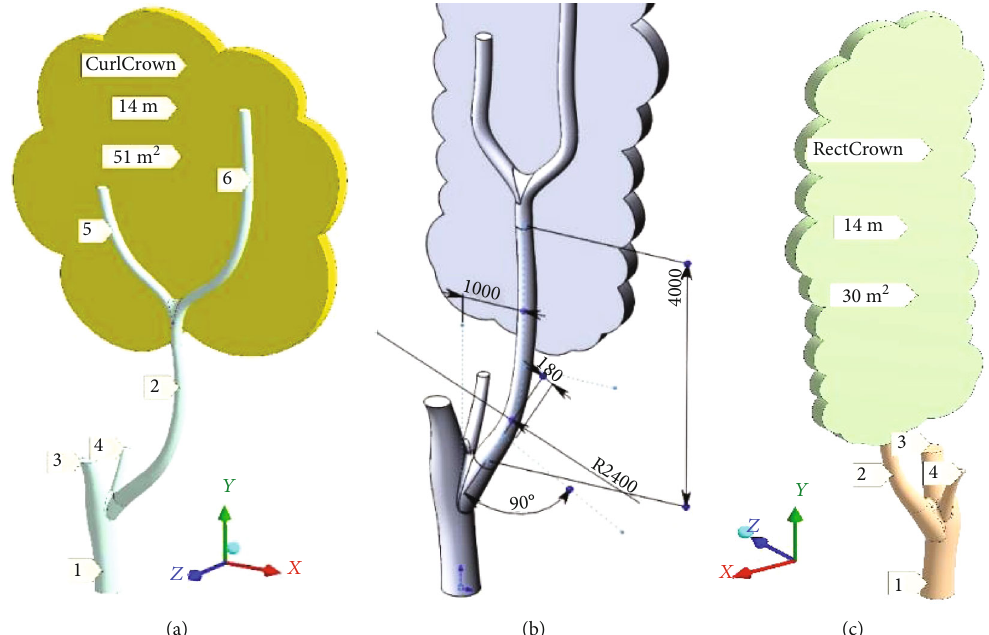
Figure 3: Tree geometry: (a) model with curled crown (CurlCrown) on the downwind side; (b) the internal dimensions of the branch; (c) elongated crown (RectCrown) from upwind.